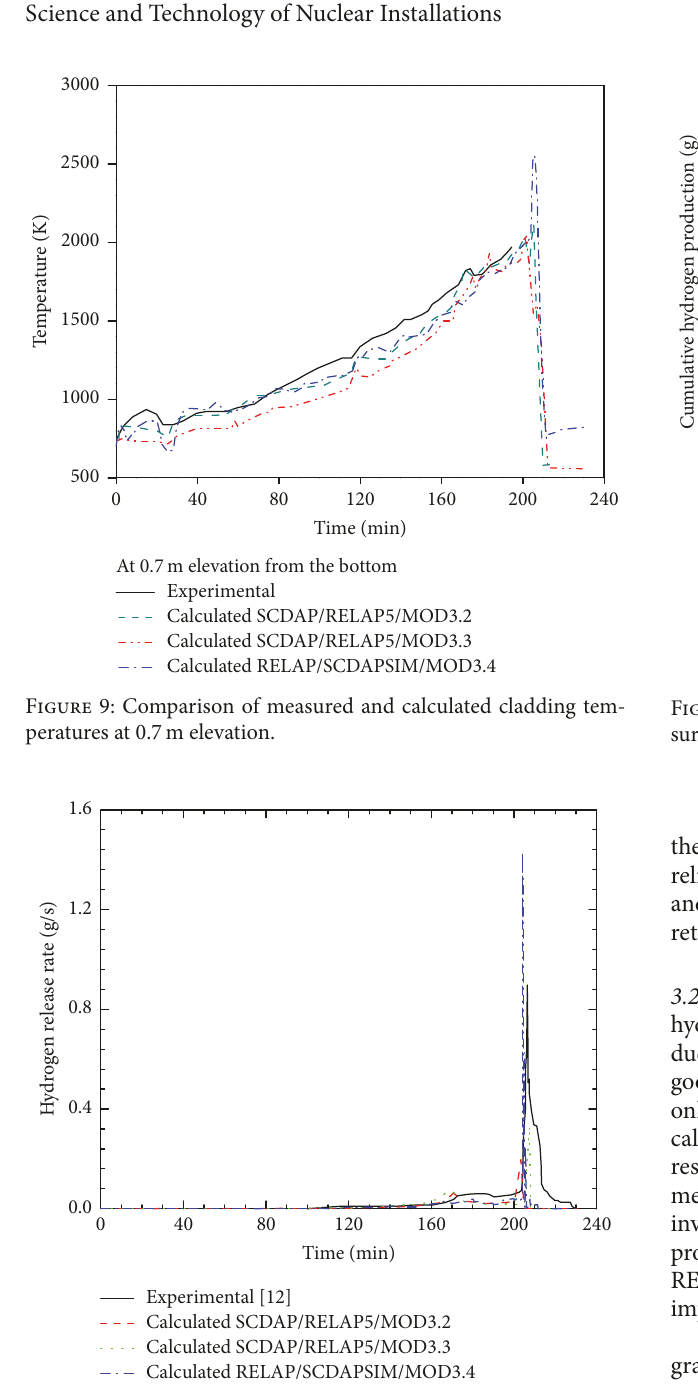
Figure 10: Comparison of hydrogen release rate measured in the experiment and predicted by the codes.